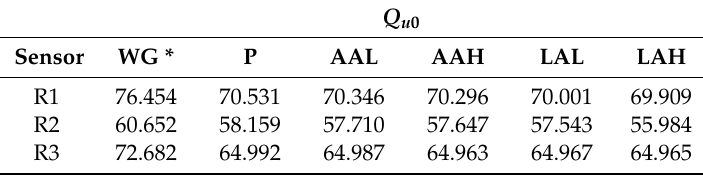
Table 3. Q u0 values obtained for the 0% added glucose measurement in each set. * Data from [43].